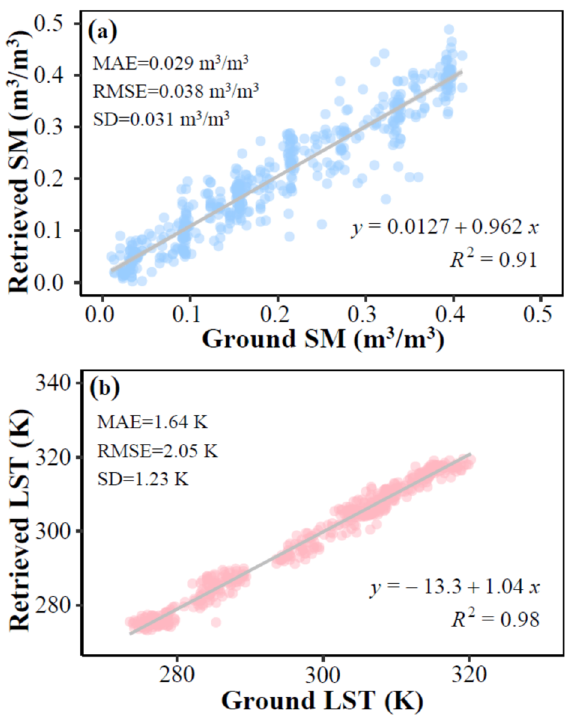
Figure 7. Comparison of ( a ) SM and ( b ) LST retrieved by the MDK-CR method and ground obser- vation data.